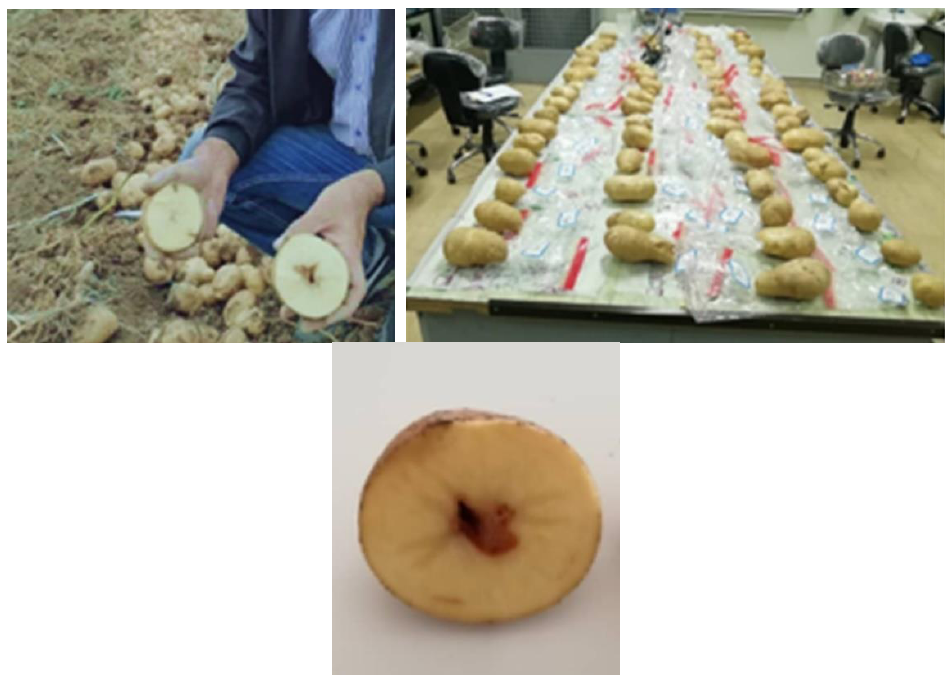
Figure 2. Cultivation and preparation of potato samples to classify them in healthy/defective classes.